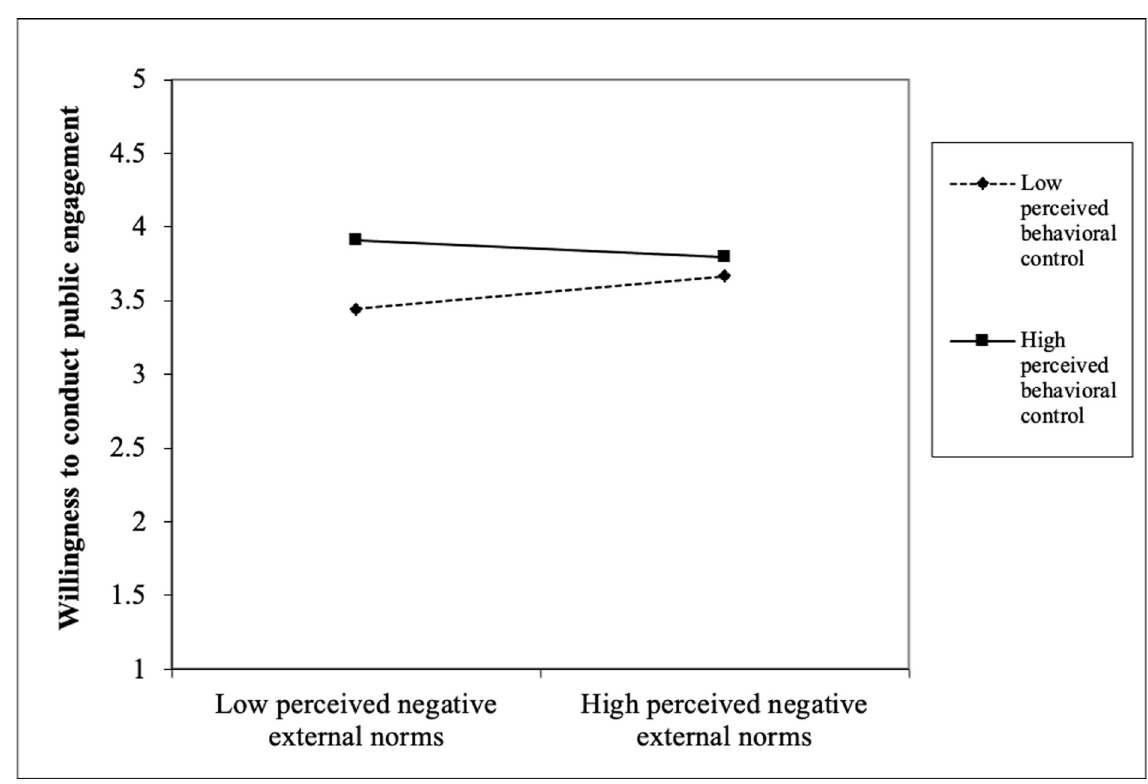
Fig 4. Perceived behavioral control as a moderator of the perceived negative external norms-willingness